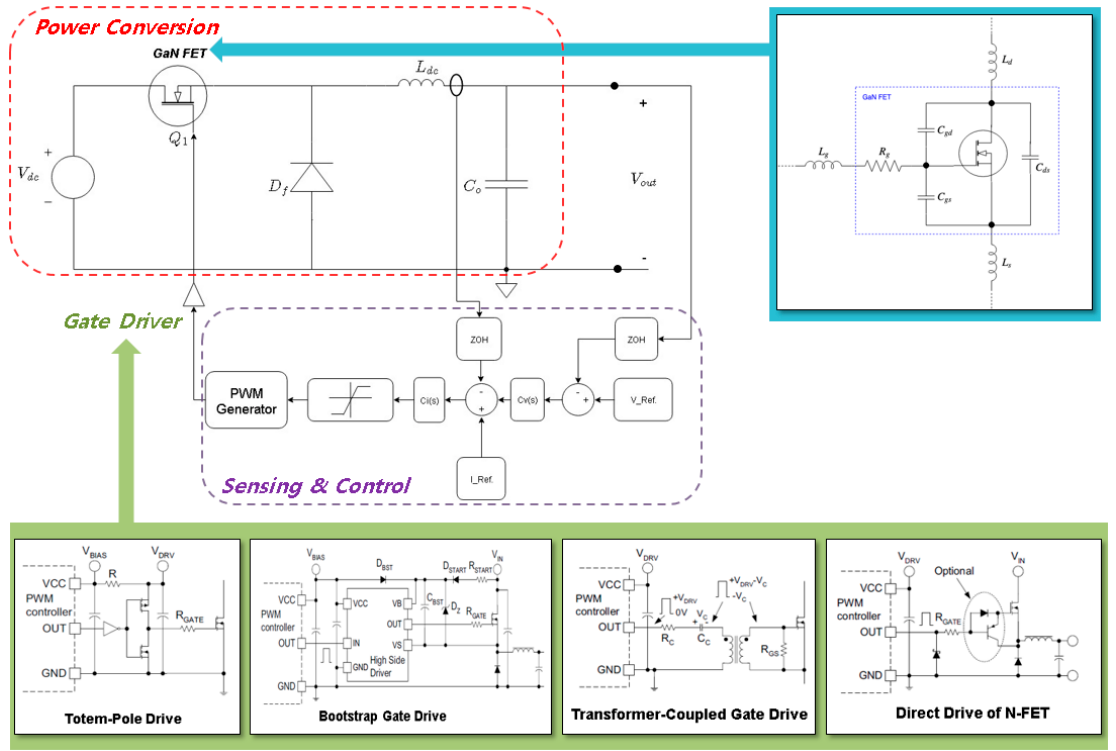
Figure 3. The step-down power conversion system structure with GaN FET , internal parameters and stray components.